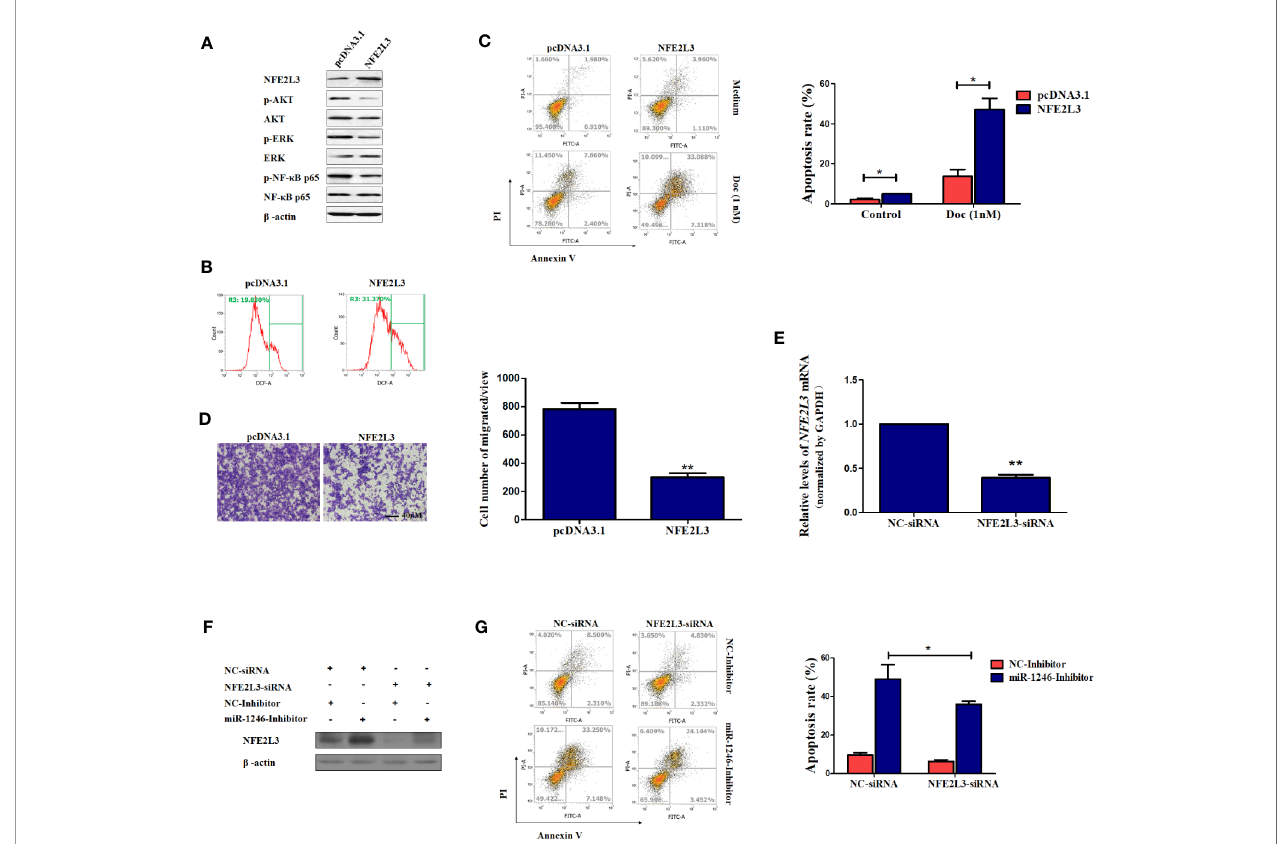
FIGURE 5 | NFE2L3 plays an important role in Doc resistance and migration in MDA-MB-231 cells. (A) After cells were transfected with NFE2L3 overexpression plasmid or empty vector for 24h, NFE2L3 expression and the activation of indicated signaling pathways were measured by western blotting. (B) Cellular ROS levels were determined by FACS with DCFDA staining in cells from (A) . (C, D) After cells were transfected with NFE2L3 overexpression plasmid or empty vector for 24h, the Doc induced apoptosis were determined by fl ow cytometry (C) and the migration ability was detected using a Transwell assay, magni fi cation: 200X (D) . (E) After cells were transfected with NFE2L3 siRNA or NC for 24h, the silence ef fi ciency of NFE2L3 siRNA was determined using qPCR. (F) MDA-MB-231 cells were transfected with NFE2L3-siRNA, miR-1246 inhibitor alone or combined. NFE2L3 expression was detected by western blotting. (G) After cells were treated as indicated, the Doc induced apoptosis were determined by fl ow cytometry. Data are presented as mean ± SD, n=3. *P < 0.05 vs. Control and **P < 0.01 vs.